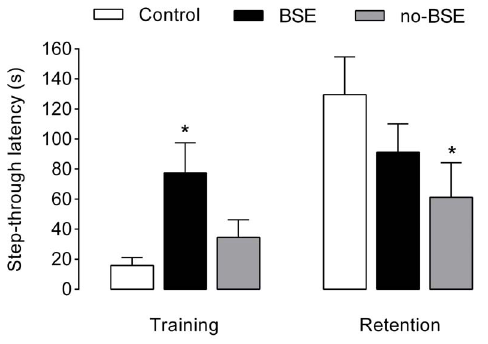
Figure 2. Performance of kainate-treated rats on the passive avoidance test. The y-axis represents the mean ( 6 SEM) step-through latencies during training trial as well as on the retention trial given 24 h later. Note that rats which did not show behavioral signs of status epilepticus following the treatment with kainate (no-BSE group) showed lower retention scores than did control rats. In contrast, rats that had experienced behavioral status epilepticus (BSE group) showed increased baseline entry latency, but appeared normal on the retention